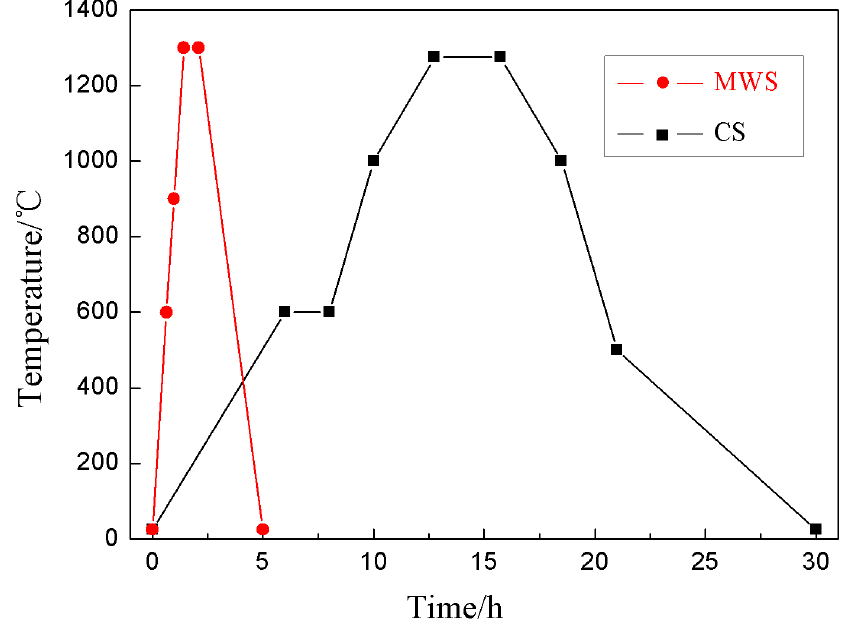
Figure 6. Time–temperature sintering curve for MWS and CS.